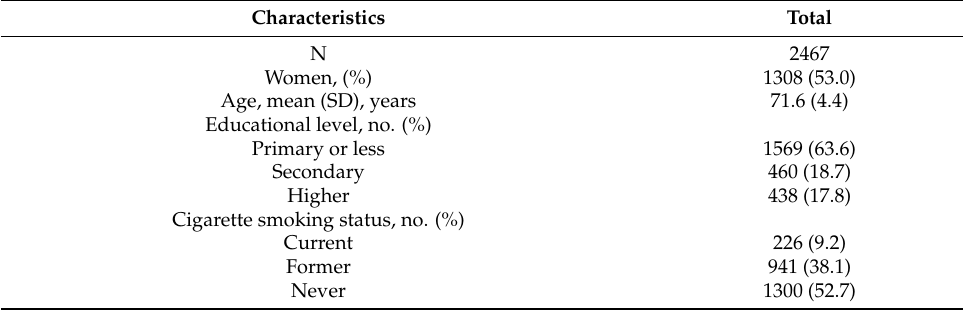
Table 1. Characteristics of the participants in the Seniors ENRICA 2 study (N =